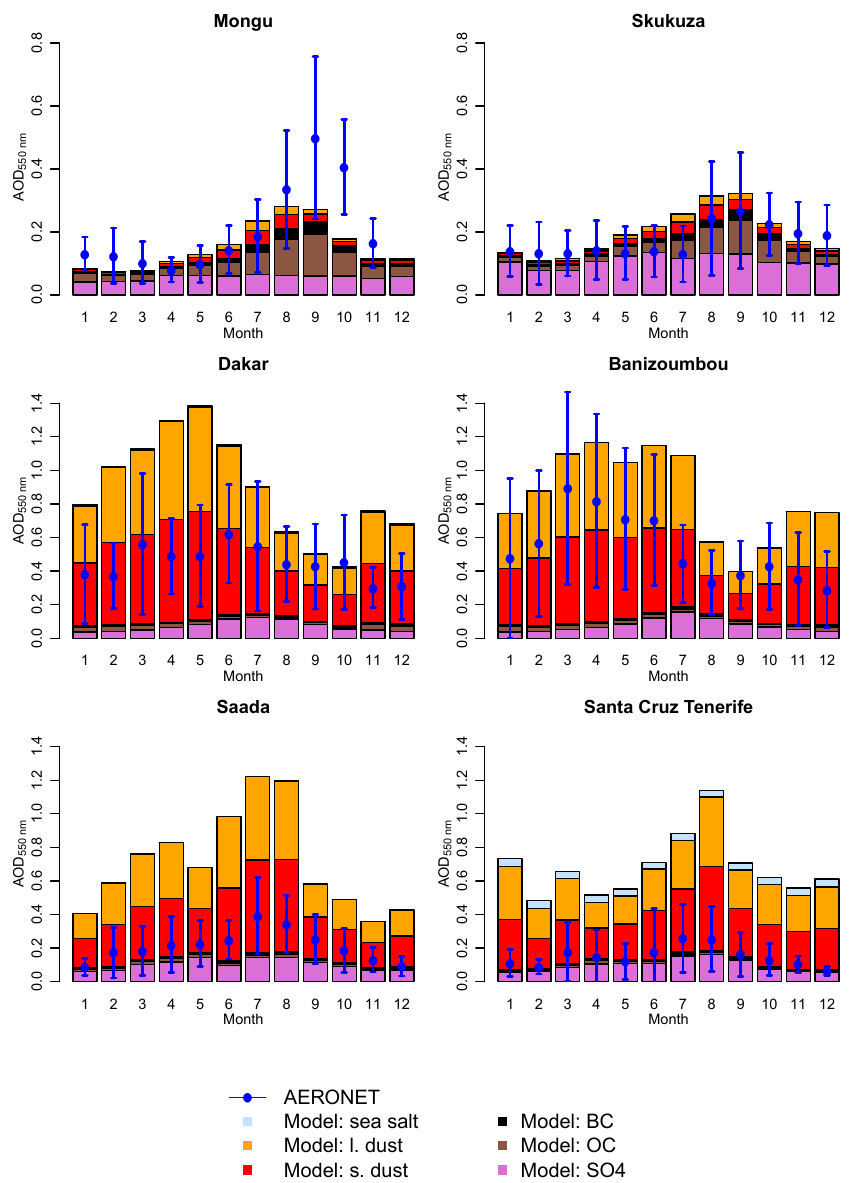
Figure 7. Multiyear mean observed vs. modeled seasonal cycle of AOD 550nm at six AERONET sites. Modeled AOD 550nm is broken down into the contribution from each aerosol species (sea salt, large size bin dust (radius ≥ 1µm), small size bin dust (radius < 1µm), BC, OC, sulfate (SO 4